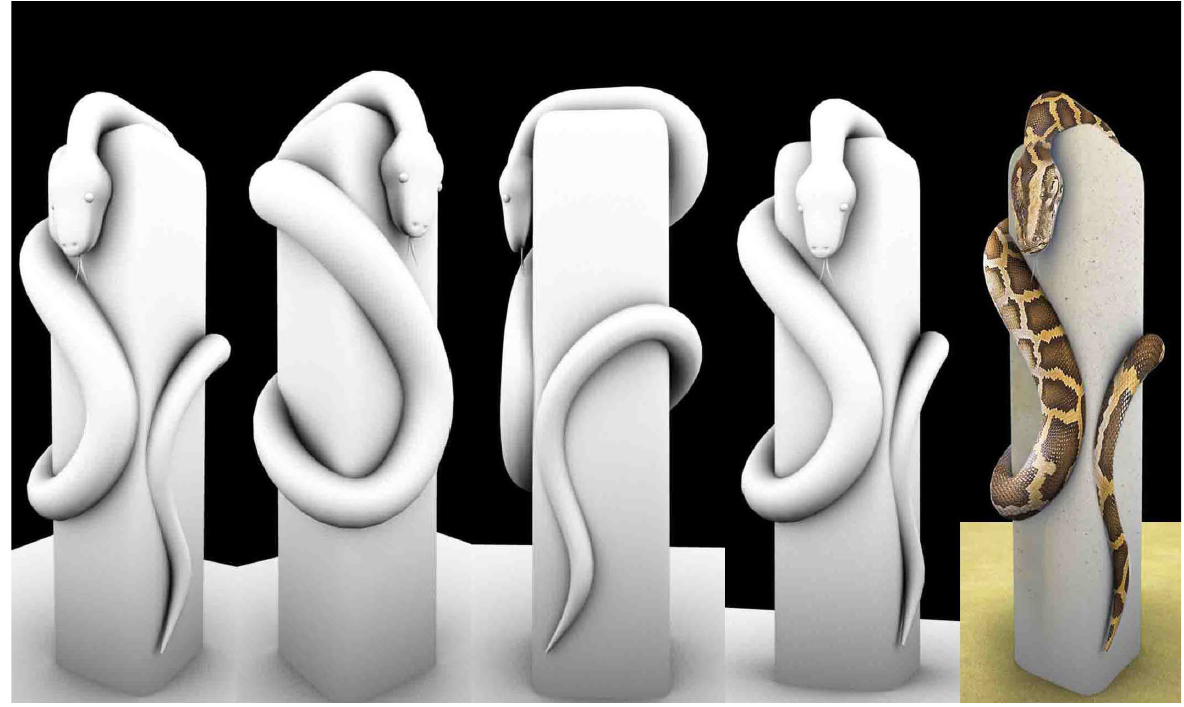
Image 14. Three-dimensional carving is an exacting process in itself but the design phase is also crucial in order to produce a satisfactory result. Shown here are 3 ds Max images which helped with the planning of the sculpture of the